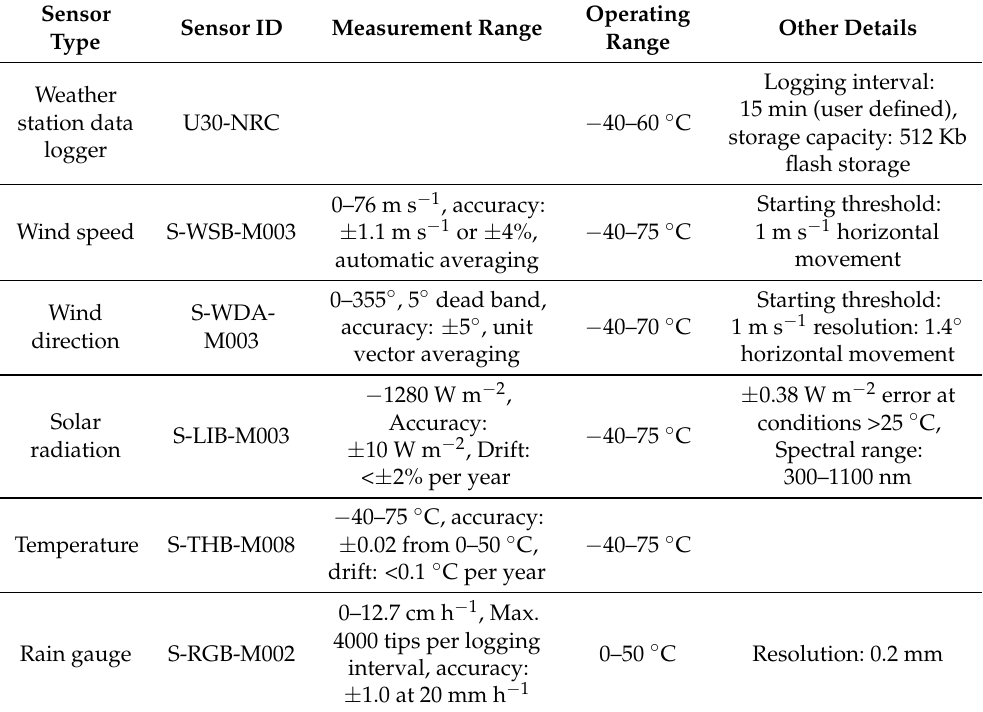
Table 2. Sensor properties according to the manufacturer Onset Computer Corporation, Bourne, MA 02532, USA